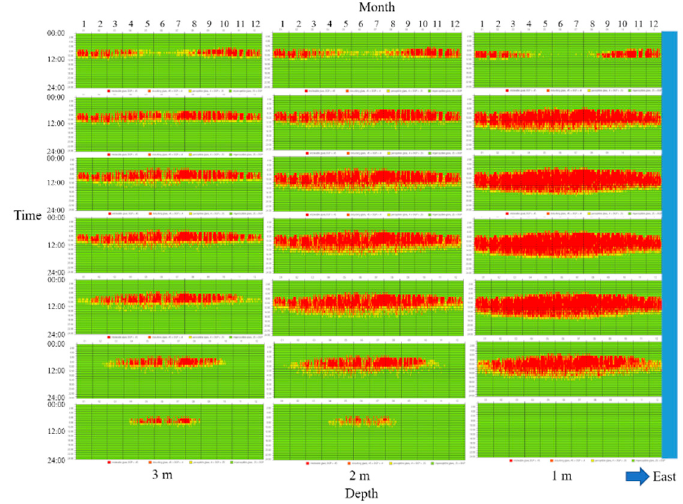
Figure 11. Annual glare level at each depth of the east-facing room.